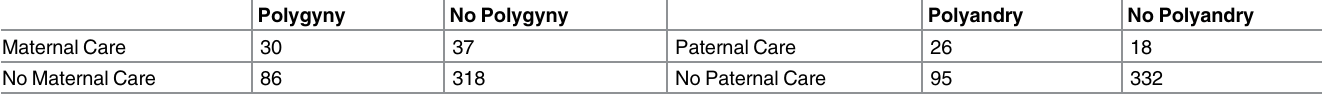
Table 13. Contingency tables of polygyny vs. maternal care and polyandry vs, paternal care among